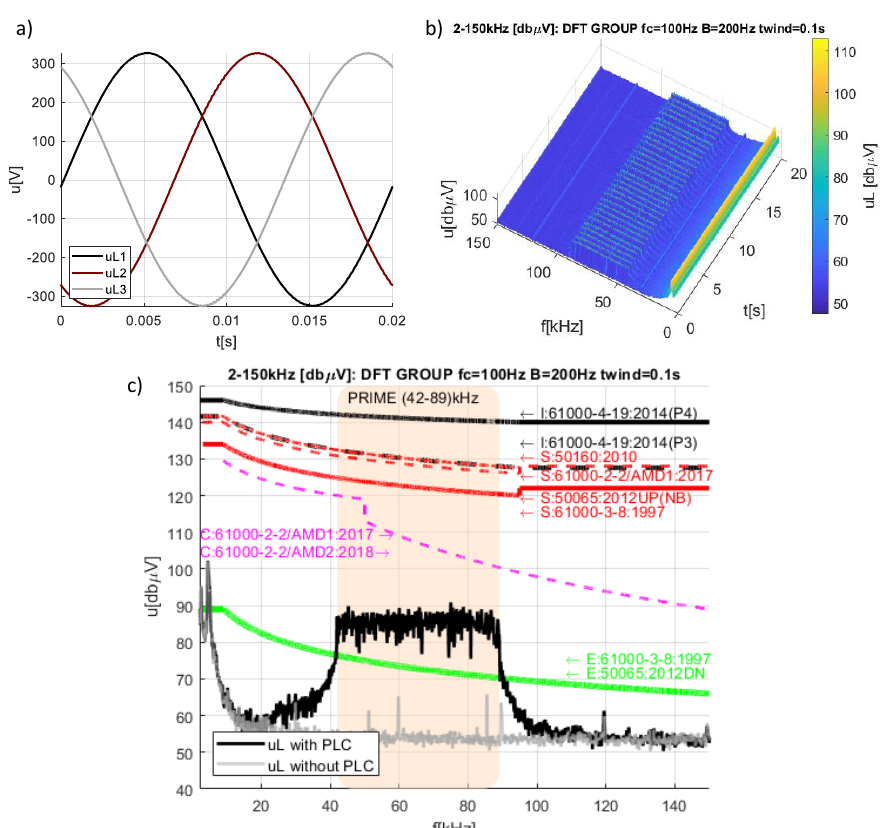
Figure 7. Case 1: Results of the analysis of PRIME PLC system operation without loads at pure sinusoidal supply voltage (reference case); ( a ) supply voltage waveform; ( b ) time-frequency representation in the range 2–150 kHz band using 100 ms window during the 20 s observation; ( c ) comparison of the spectrum of the corresponding PRIME PLC transmission (black) and the spectrum of the voltage in the connection point of the load and energy meter (grey) with relation to the normative curves (uL—line voltage in the point of the equipment connection, which is also the point of energy meter connection with PRIME PLC).